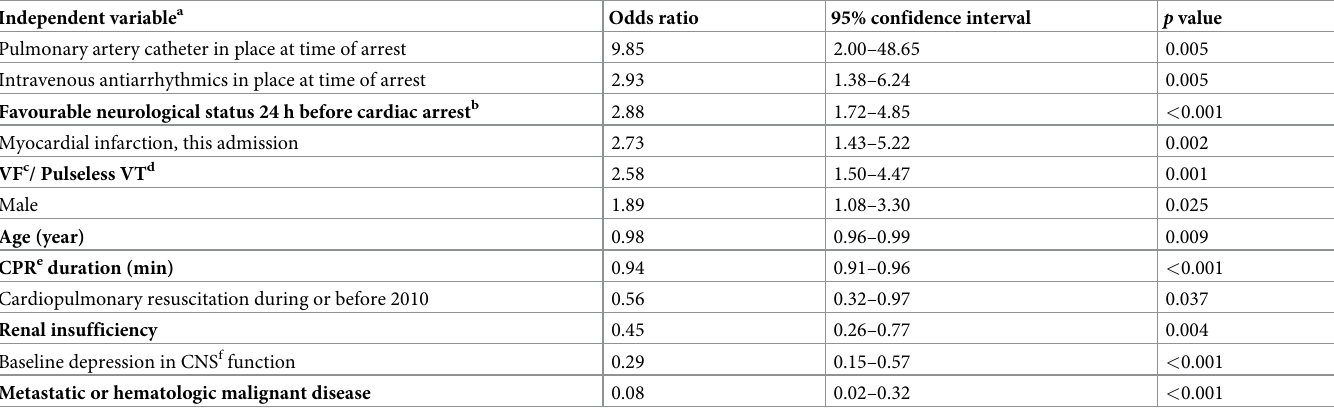
Table 3. Multiple logistic regression model with favourable neurological outcome at hospital discharge as the dependent variable.